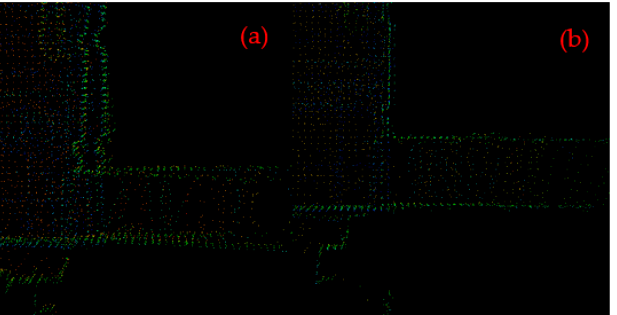
Figure 13. Partial enlargement of the map for scene #1. ( a ) By LeGO-LOAM; ( b ) by LeGO-LOAM- SC.